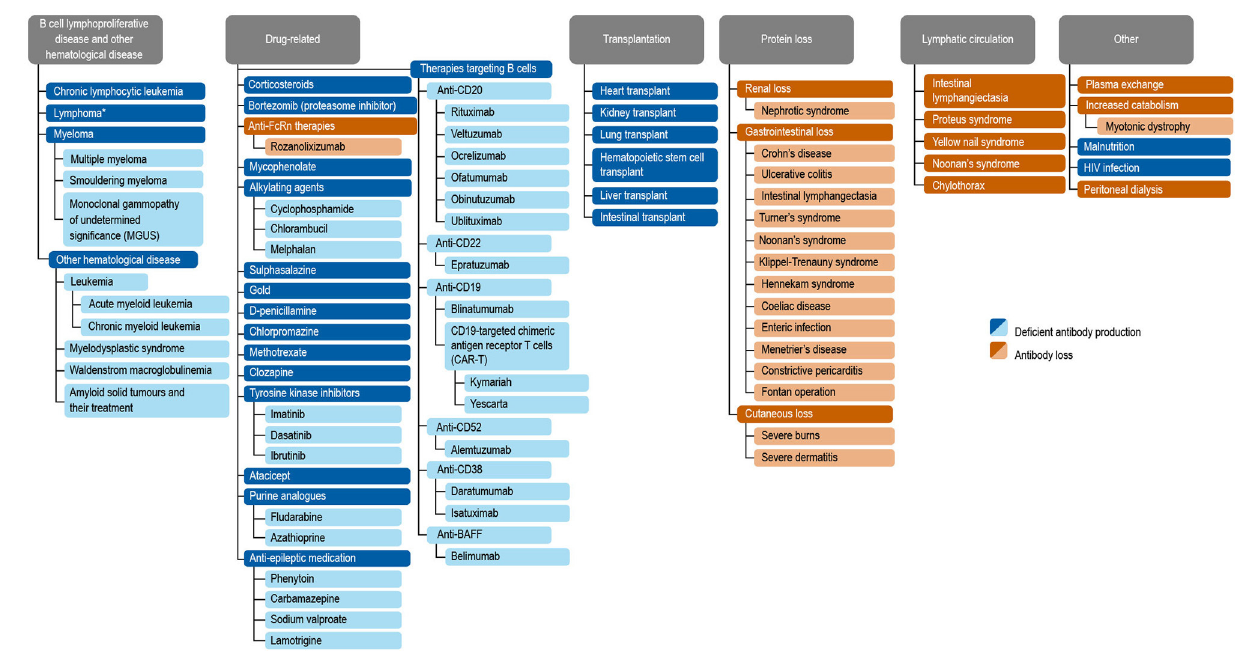
FIGURE 1 | Common causes of secondary antibody deficiency (26), (5), (251), (255), (256), (242), (6), (144), (7), (165), (70), (242), (18), (168), (244), (134), (141), (135), (139), (133), (155), (245), (147), (138), (38), (162), (124), (163), (246), (174), (233), (253), (257), (247), (252), (249), (250), (10), (254). Reproduced with the permission